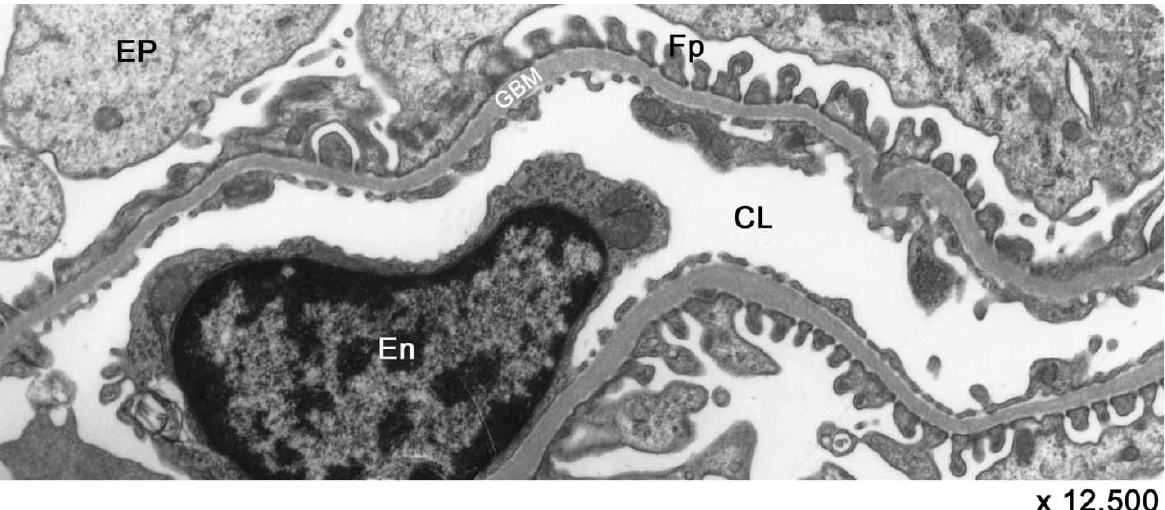
Figure 7. Glomerular capillary loops of a control rKF3 antigen-injected rat. The glomerular capillary loop and its related structures show no morphological alterations ( £ 12,500). CL, capillary-loop; En, endothelial cell; Ep, epithelial cell; Fp, foot process; GBM, glomerular basement